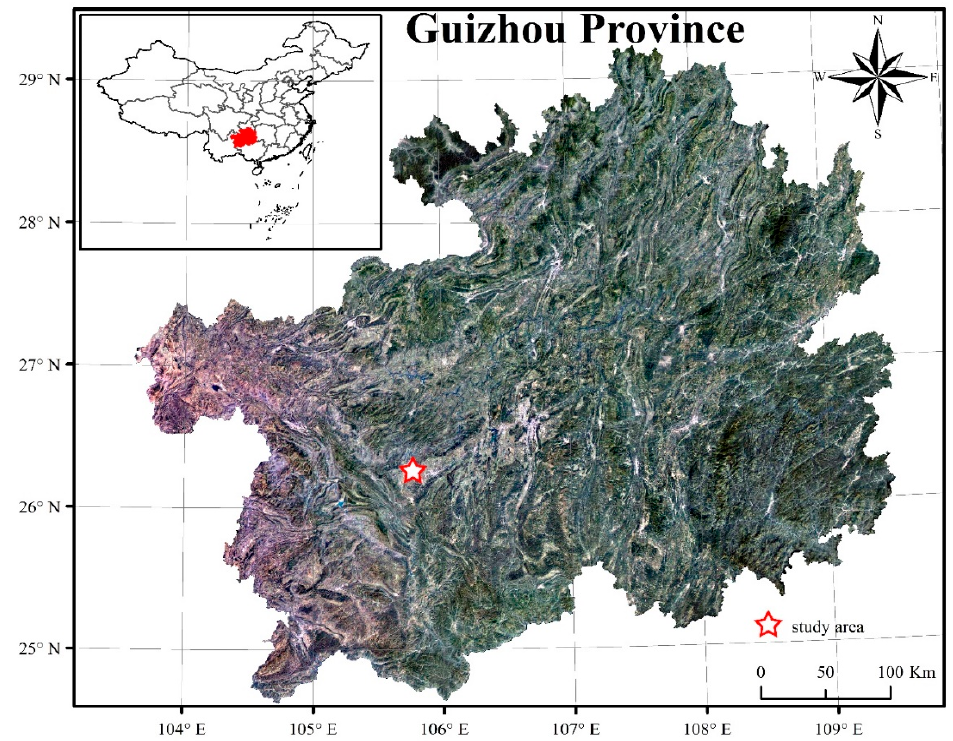
Figure 1. Location of the study area in China.